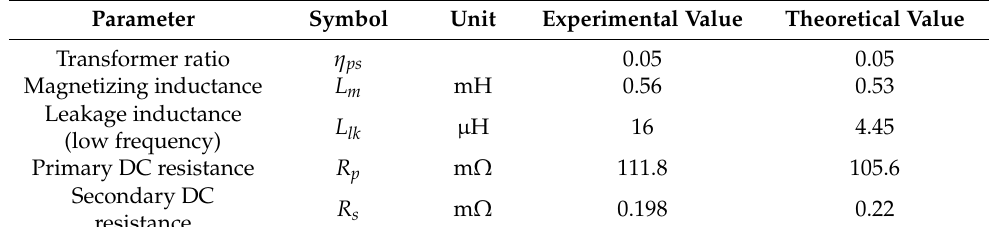
Figure 9. Planar transformer equivalent circuit. Table 2. Planar transformer electrical characteristics.